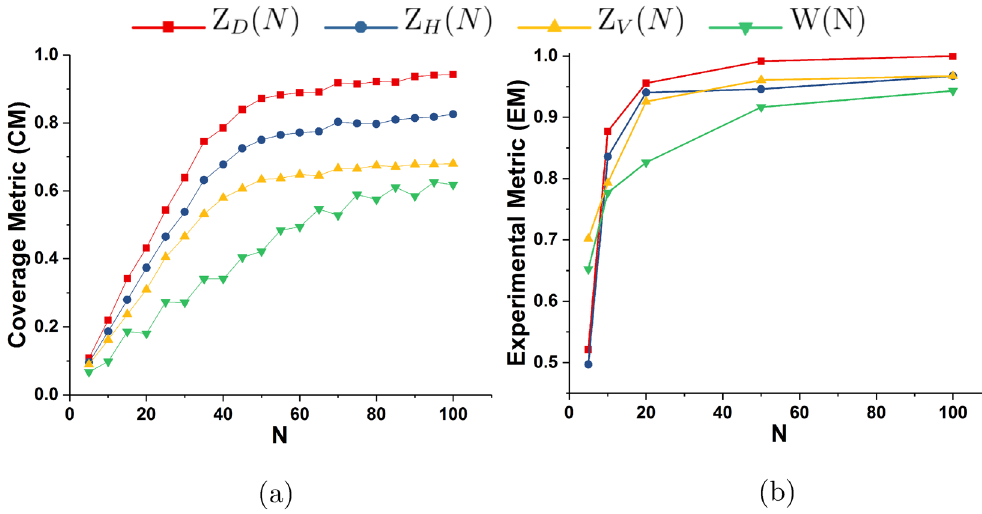
Figure 6. ( a ) Coverage Metric ( CM ) and ( b ) Experimental Metric ( EM ) as a function of N for four different acquisition schemes.